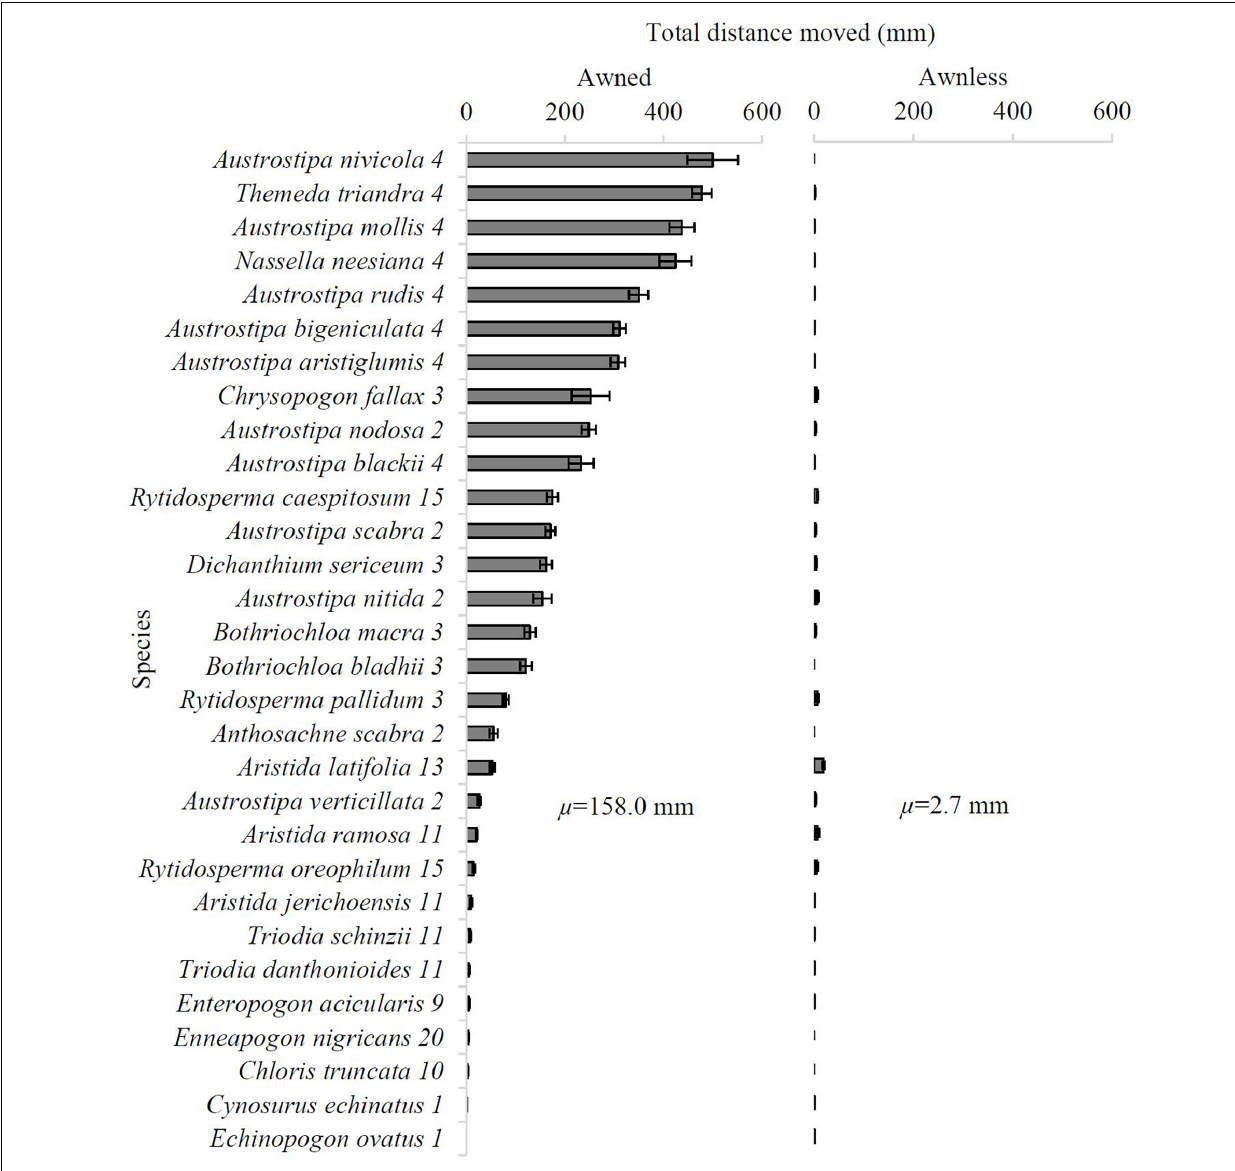
FIGURE 2 | Mean total distance moved (TD A ) (in mm) by diaspores across a hardboard in the surface dispersal experiment after five wet-dry cycles for the 30 study species in both the Awned (nine replicates per species) and Awnless (awn removed) (six replicates per species) treatment. Error bars represent one standard error. Species name is followed by awn type (see Table 1 ). µ = mean TD A (mm) of each